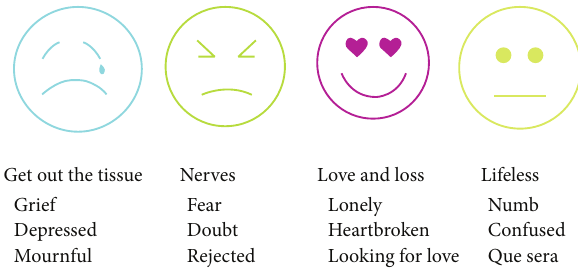
Figure 2: Activate Mood Marketing Chart—Project